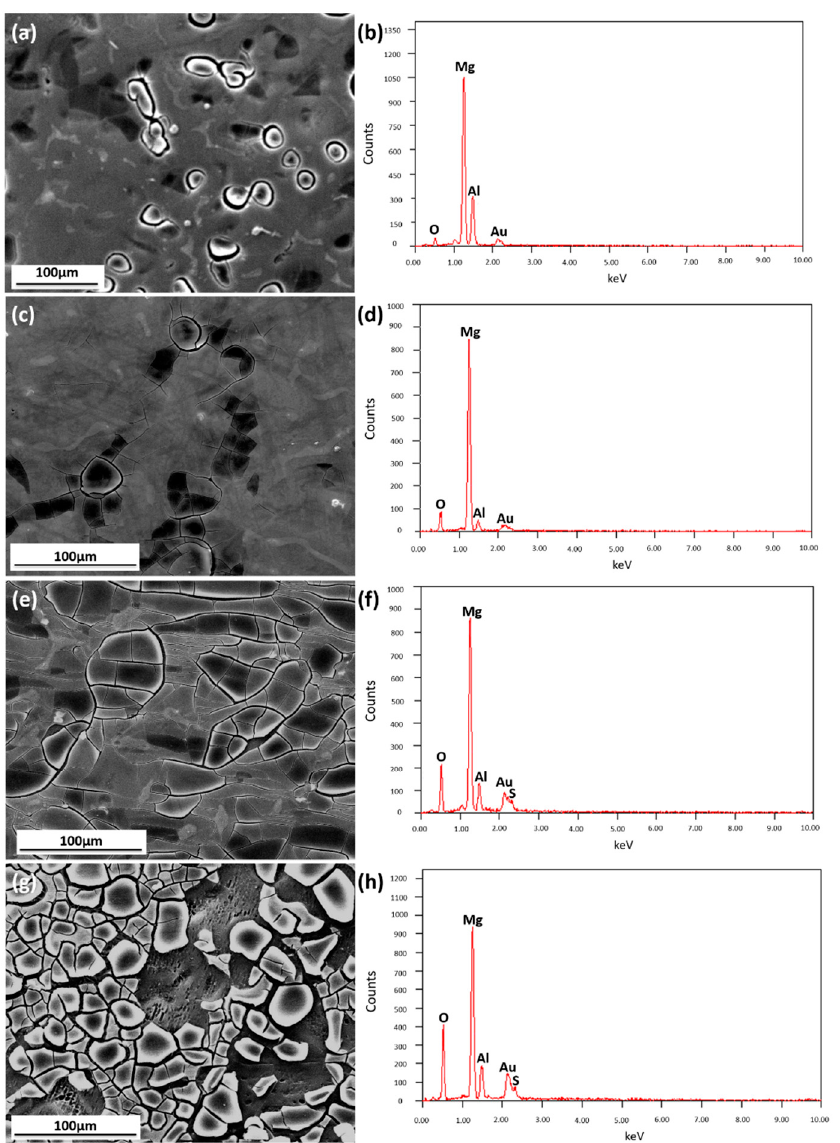
Figure 7. SEM ( a , c , e , g ) images and EDX results of samples immersed in solution for 1.5 h ( a , b ), 3 h ( c , d ), 8 h ( e , f ) and 48 h ( g , h ).